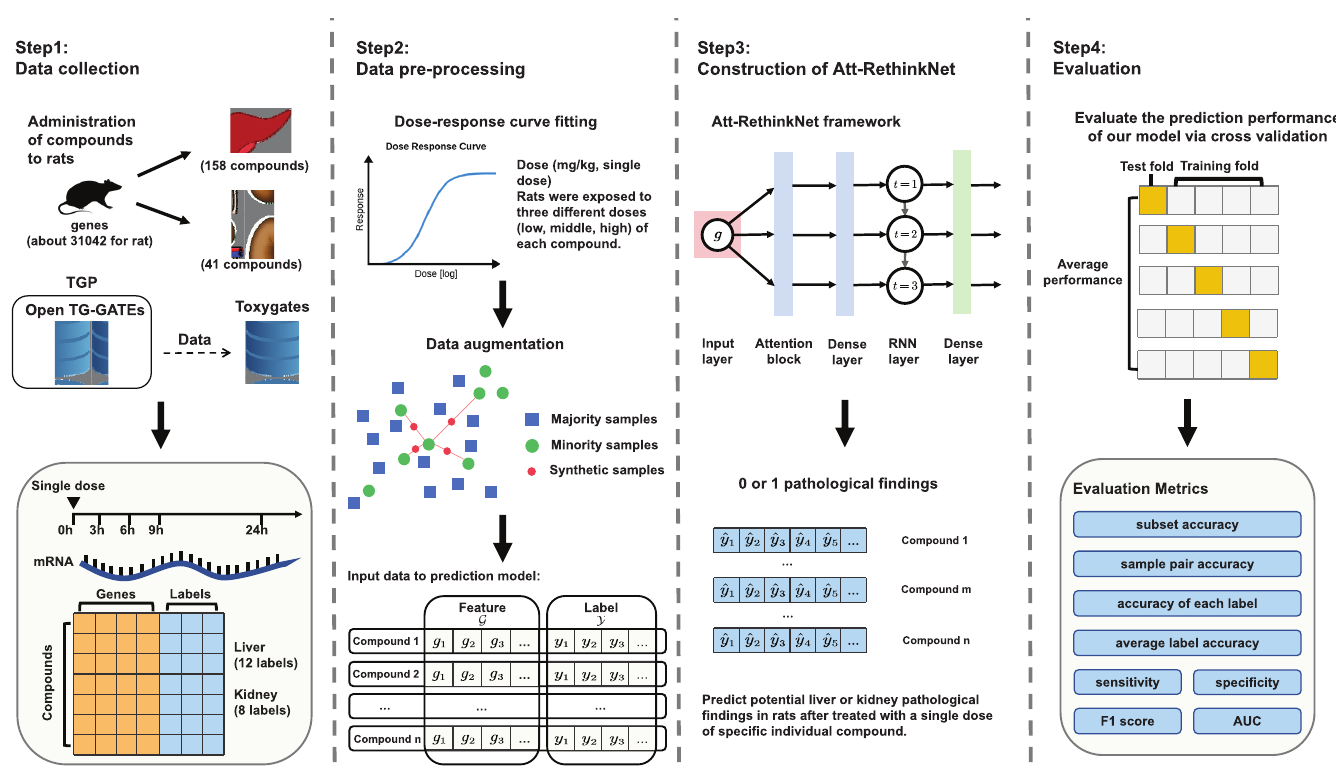
Fig 1. The work flow of the proposed method. We have four steps for the proposed method, data collection, data pre-processing, construction of the proposed Att- RethinkNet model and evaluation of the Att-RethinkNet.